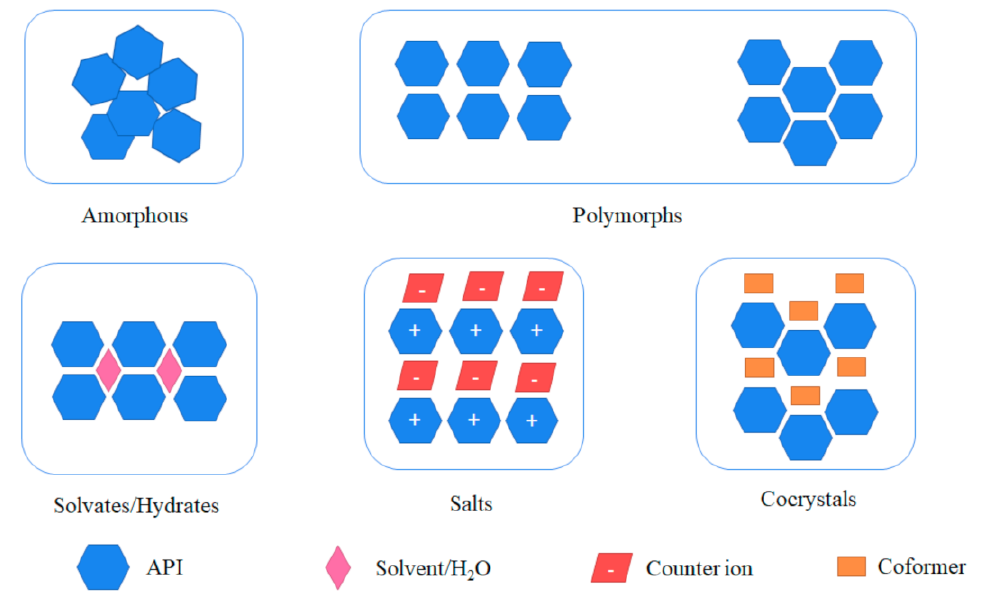
Figure 1. Different solid-state forms of an